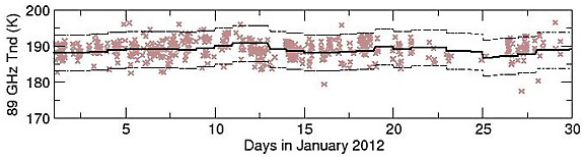
Fig. 5. Self-calibration of the ARM MWR3Cs. Brown points are the instantaneous noise injection temperature values derived from tip curves. The black solid line is the median calculated value and the dashed lines are 2 standard deviations of the measurements. The data collected at the TWP-Darwin site in January 2012.